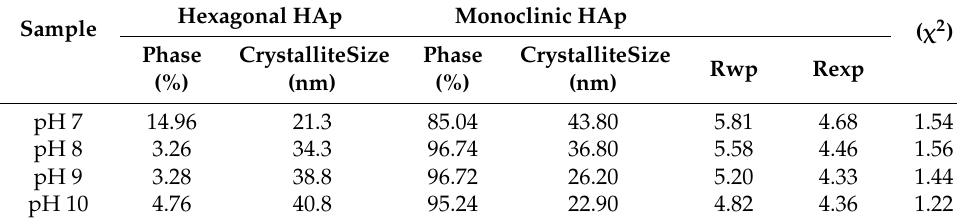
Table 5. Obtained phases and crystallite size by Rietveld